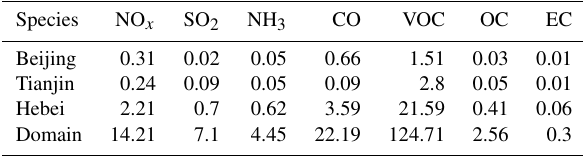
Table 1. Anthropogenic emissions of various species in the simula- tion domain in October 2015 (unit: Mtonmonth − 1